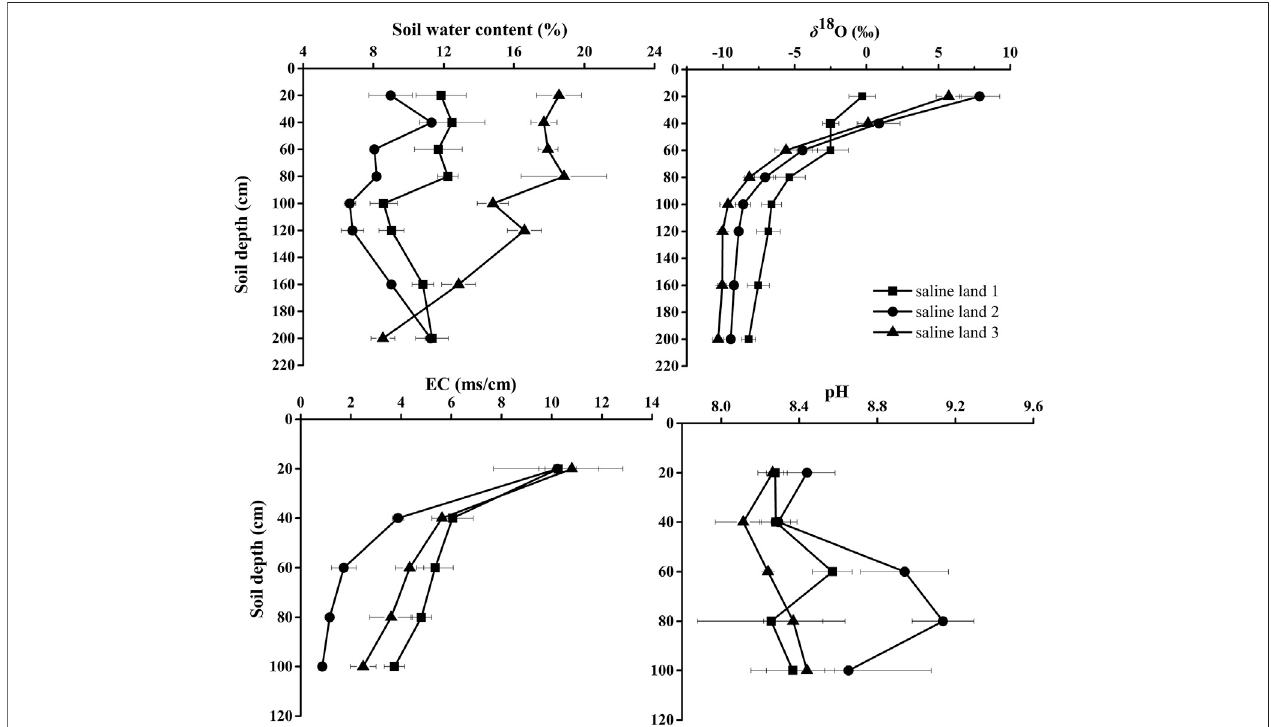
FIGURE 1 | Variation in soil water content, soil water δ 18 O values, soil electrical conductivity (EC) and pH along soil pro fi les in the three saline sites. Data are presented as mean ± 1 SE.